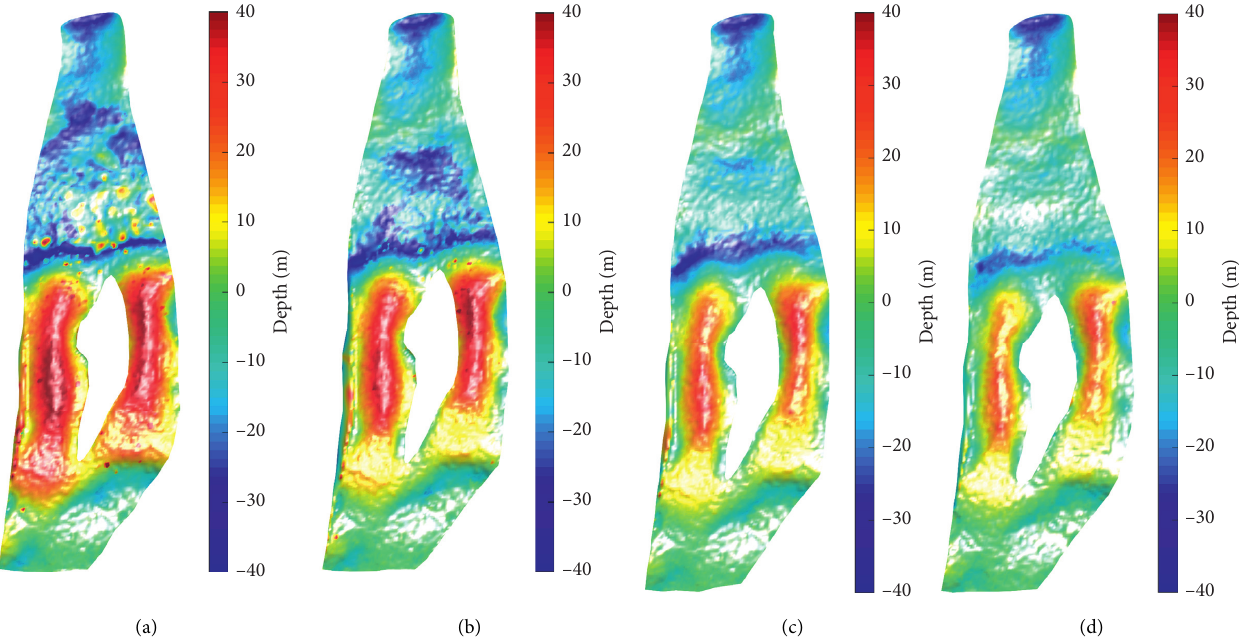
Figure 12: Distribution of scraping depth and deposit thickness of four materials with different strengths. (a) Material 1, (b) Material 2, (c) Material 3, and (d) Material 4.